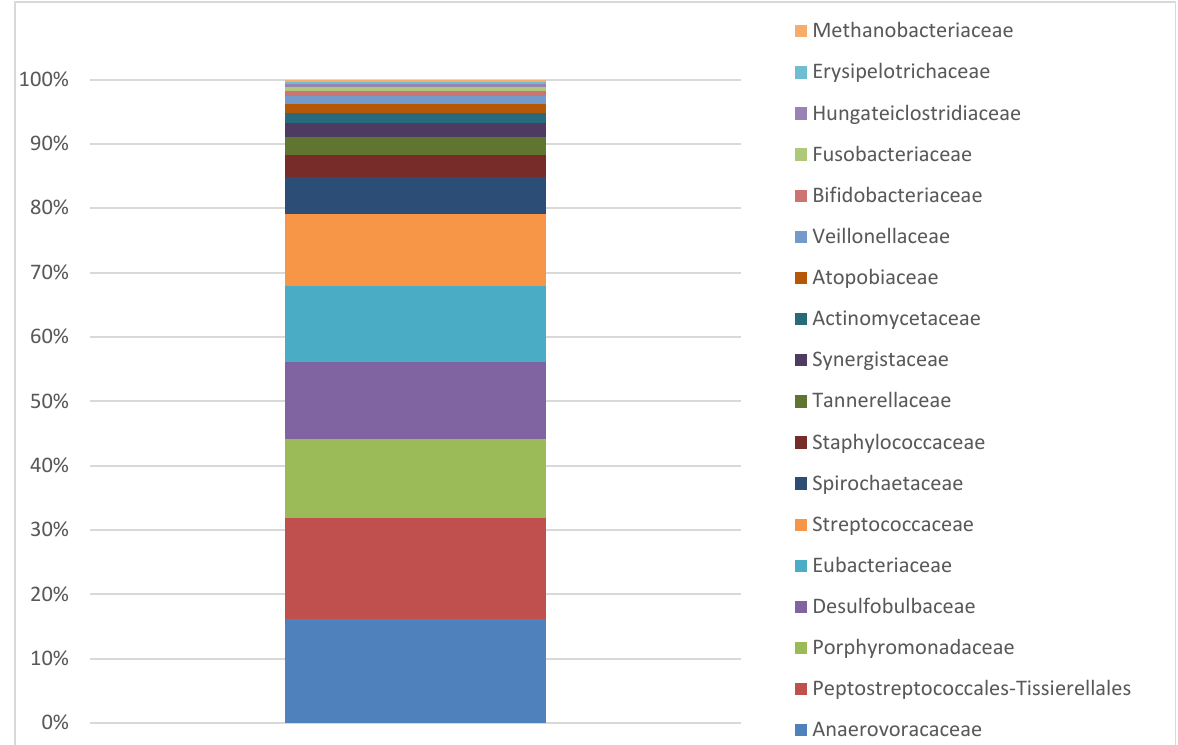
Figure 3. Abundance of bacterial families in the collective sample of implants removed from the patients with peri-implantitis after 8 and 25 years of use.